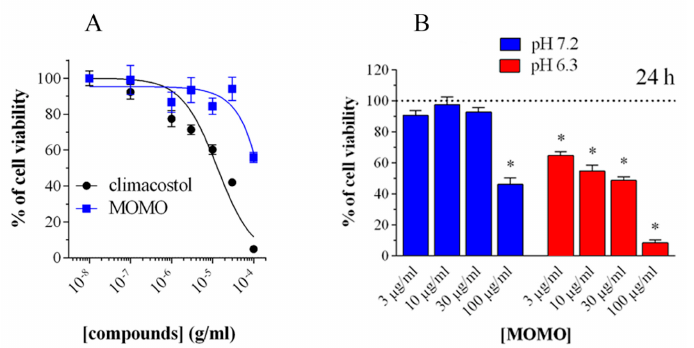
Figure 9. Cytotoxicity of methoxymethyl ether (MOM)-protected climacostol (MOMO) in melanoma cells. ( A ) 3-(4,5-dimethylthiazole-2-yl)-2,5-diphenyltetrazolium bromide (MTT) colorimetric assay on mouse B16-F10 cells, treated with increasing concentrations of MOMO and climacostol for 24 h. ( B ) Increasing concentrations of MOMO in physiologic (pH 7.2) and acidic (pH 6.3) culture medium for 24 h of incubation. Data are representative of at least 6 independent experiments. * p < 0.0001 relative to the respective control. Modified from [39] and reproduced under the Creative Commons